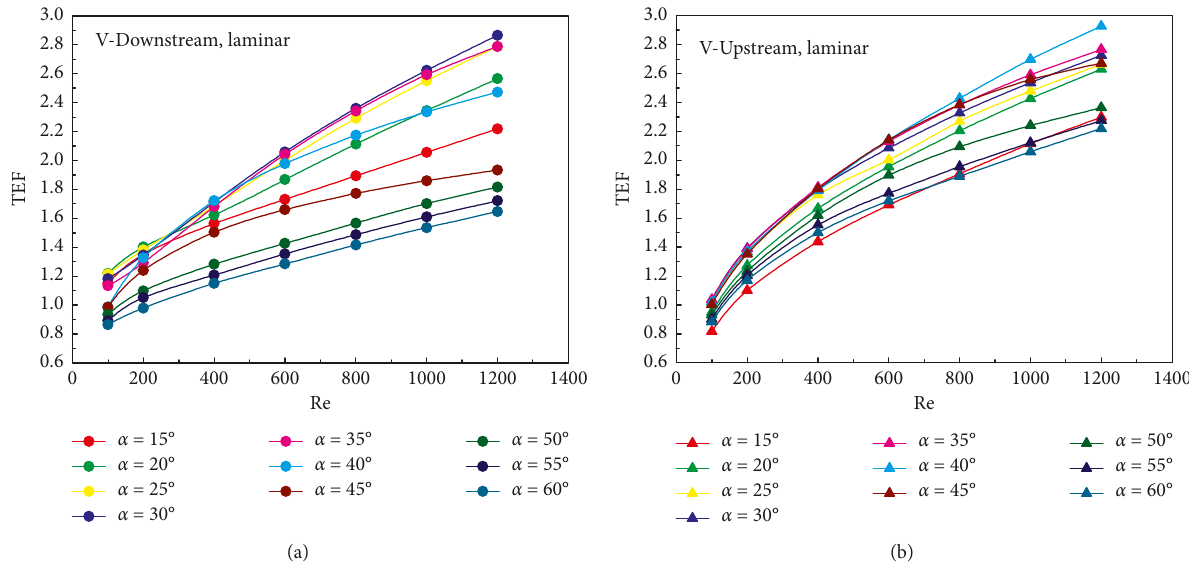
Figure 11: Relations of the TEF with Re for the heat exchanger tube inserted with the V-wavy surface for (a) V-Downstream and (b) V- Upstream at the laminar regime.